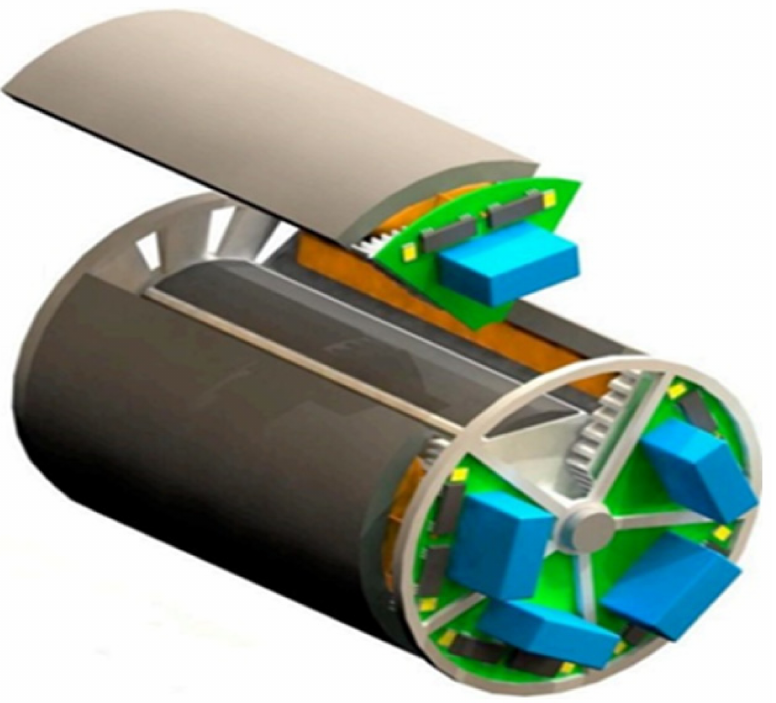
Figure 2. Integrated structure of generator and